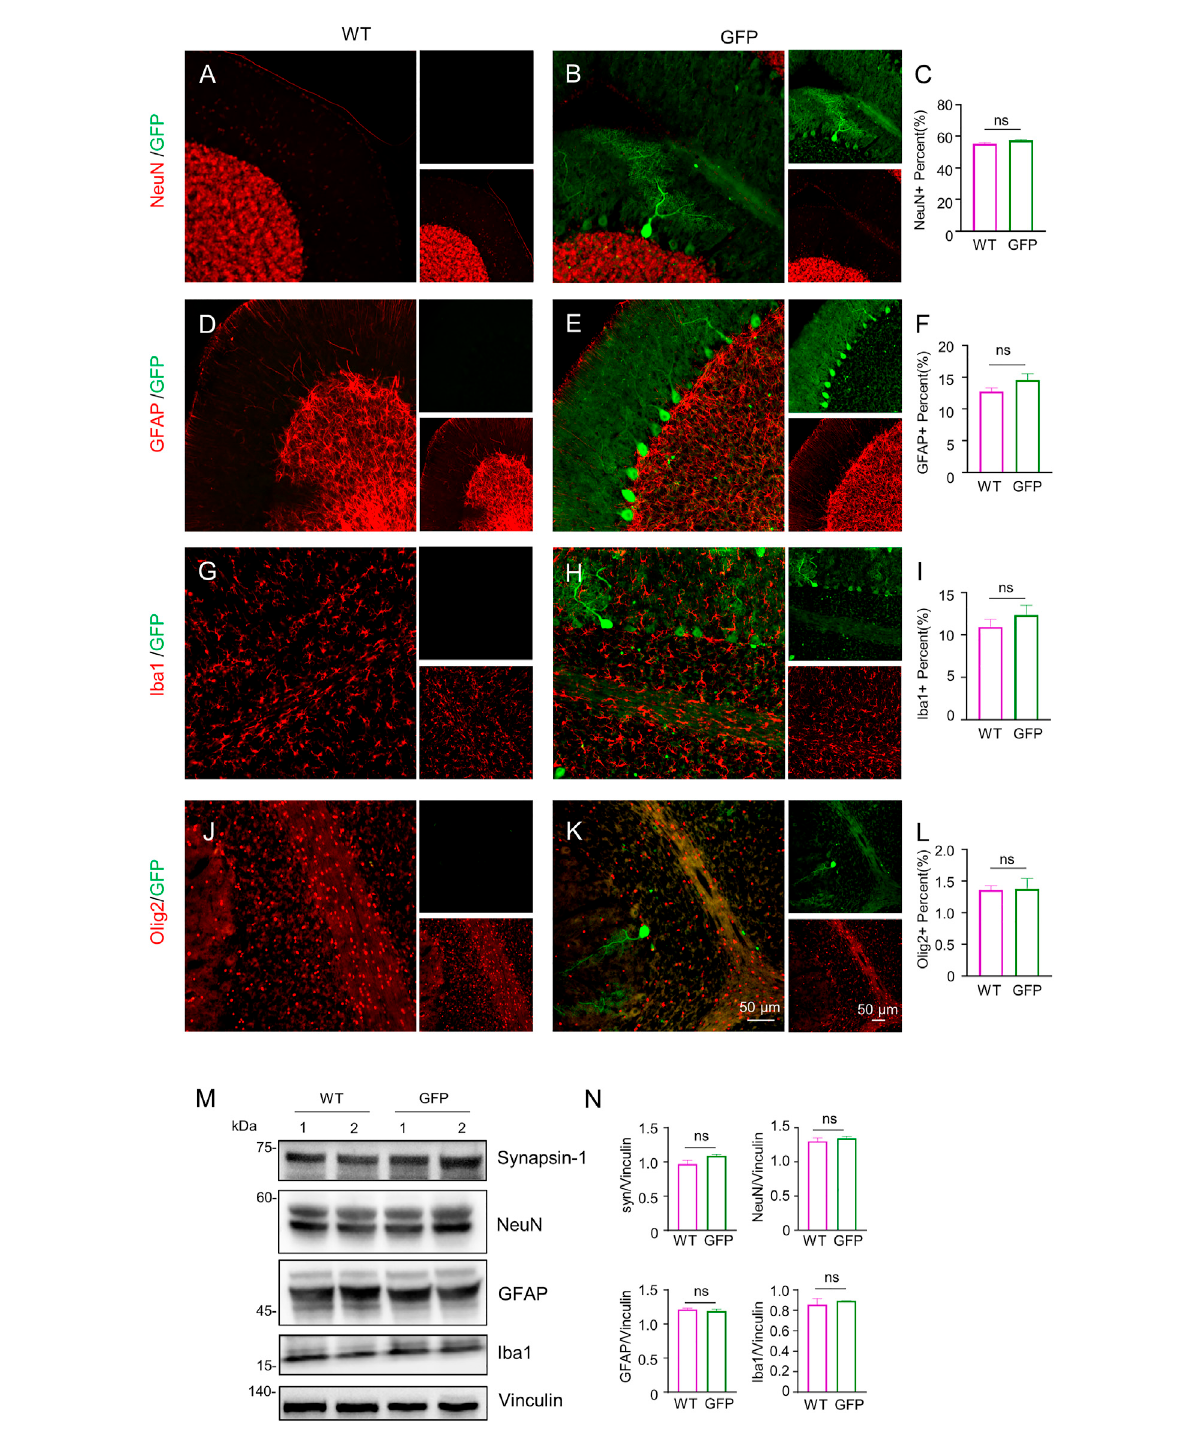
FIGURE 5 Immuno fl uorescent staining of the pigs ’ cerebellum injected with AAV-GFP or saline. (A – L) Double immuno fl uorescent labeling and quanti fi cation of neurons (NeuN) (A – C) , astrocytes (GFAP) (D – F) , microglial (Iba1) (G – I) and oligodendrocytes (Olig2) (J – L) of saline- or AAV-GFP- injected-wild type pigs. GFP positive cells are shown in green, NeuN, GFAP, Iba1 and Olig2 positive cells are shown in red. Data are analyzed by Student ’ sT-testandpresentedasmean±SEM. n =3animalspergroup. (M) WesternblottingofthecerebelluminjectedwithsalineorAAV-GFP using antibodies against synapsin-1, NeuN, GFAP and Iba1. Vinculin served as a loading control. (N) Quantitation of the ratios of synapsin-1, NeuN, GFAP or Iba1 to vinculin on the western blots. Data are analyzed by student ’ s T-test and presented as mean ± SEM. n = 3 animals per